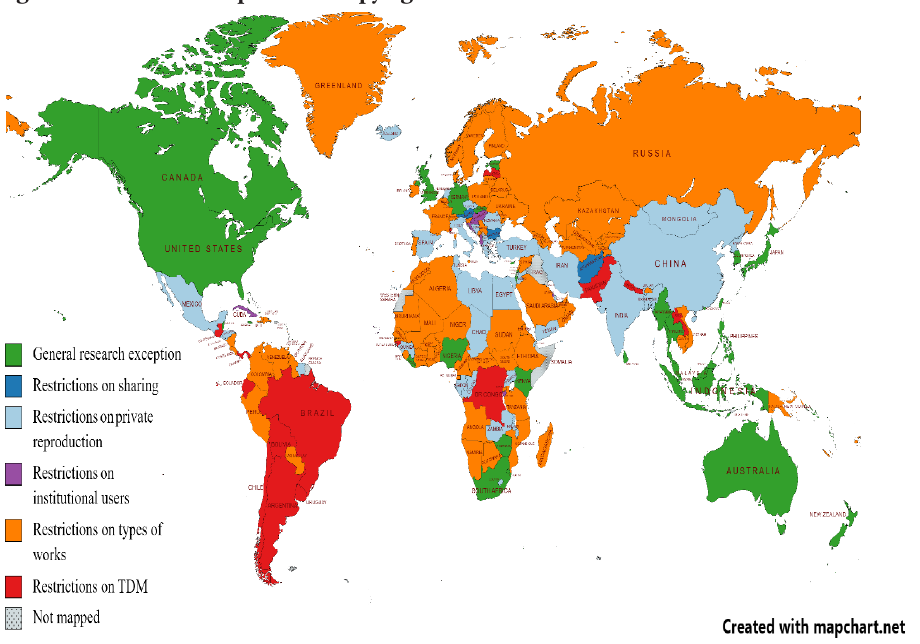
Figure 1: Research exceptions in copyright